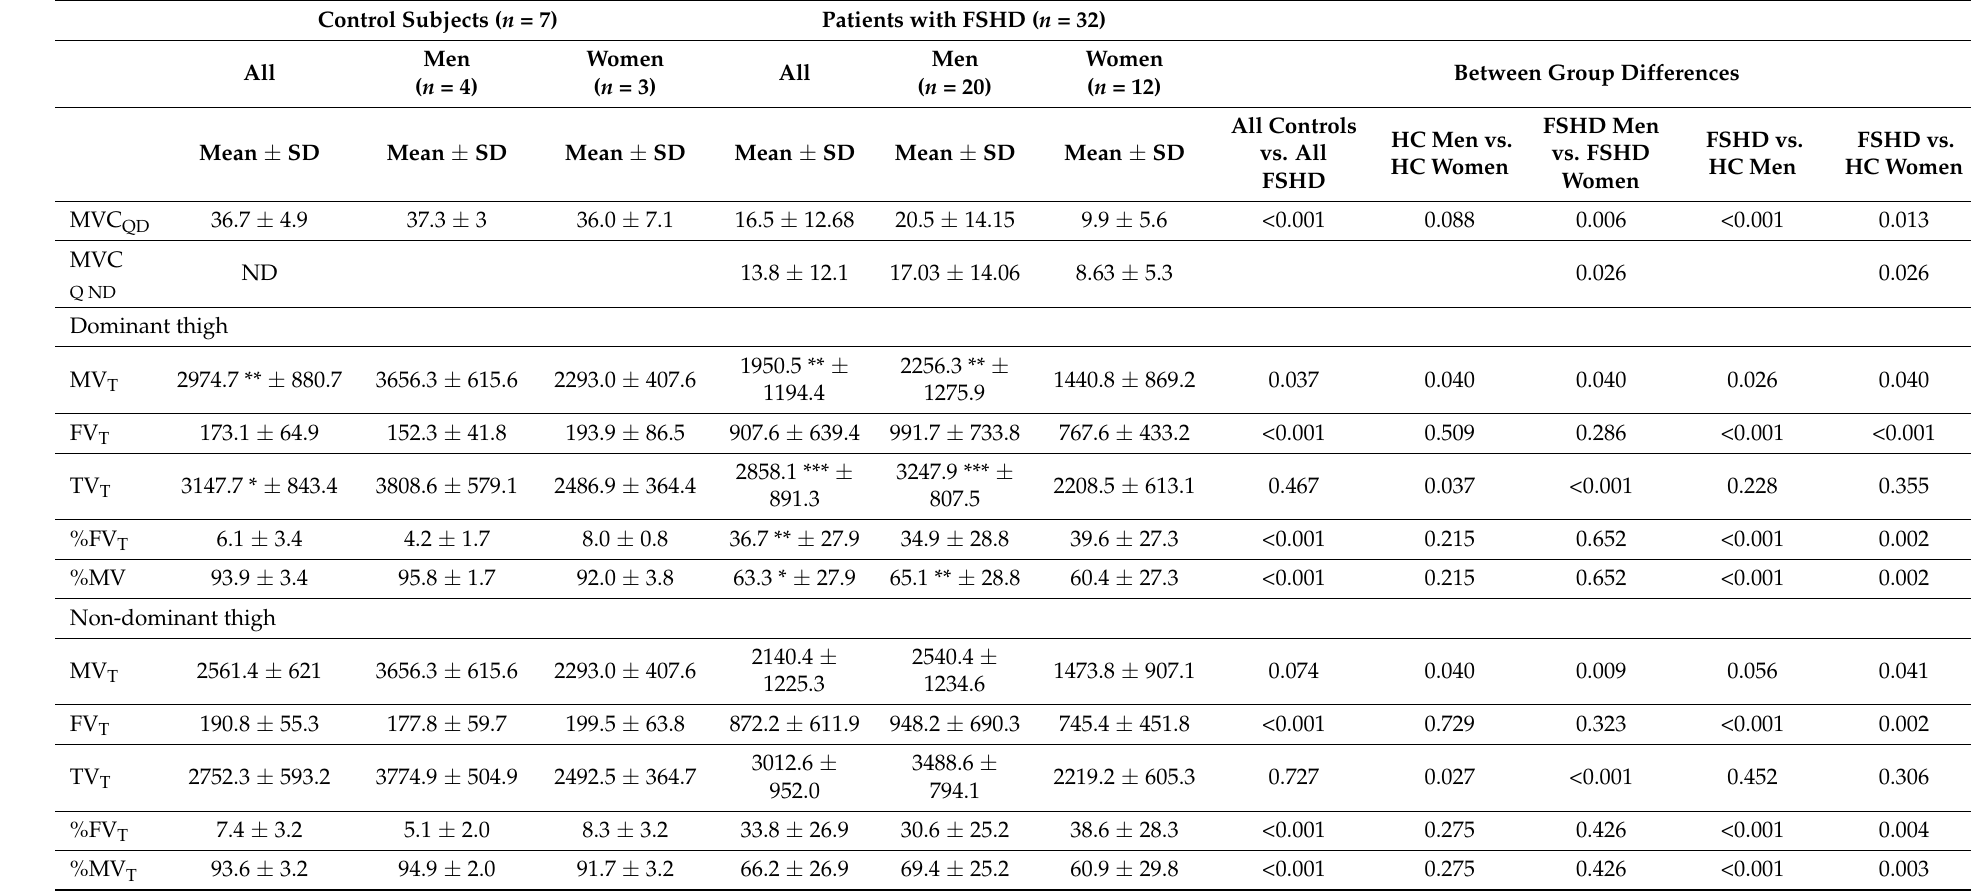
Table 13. MRI evaluation of thigh parameters in patients with FSHD and healthy